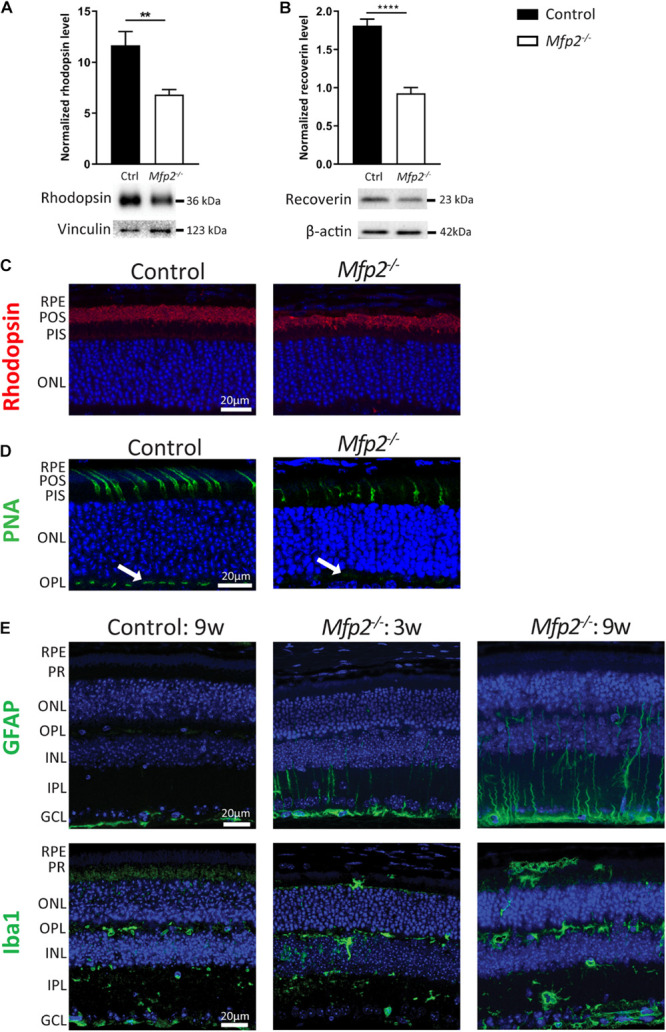
MFP2 ablation affects both rods and cones and causes secondary glial activation. Western blot analysis of (A) rhodopsin and (B) recoverin reveal decreased protein levels in 3 weeks-old Mfp2–/– retinas. Vinculin and β-actin are used as loading control in (A,B), respectively. Mean ± SEM are shown (n = 5-9 per genotype). Statistical significance was determined by unpaired t-test: ** p < 0.01, **** p < 0.0001. (C) IHC for rhodopsin reveals shorter POS length and no mislocalization of the protein. (D) PNA-labeled cones exhibit a reduction in length in Mfp2–/– retinas. Cone pedicles in the OPL (white arrows) show a decrease in signal intensity. (E) IHC for GFAP and Iba1 shows the activation of Müller cells and microglia, respectively, in the MFP2 deficient retinas of 3 and 9 weeks-old mice. In addition to their activation, microglia also migrate toward the subretinal space. Hoechst (blue) was used as nuclear counterstain (n = 3 per genotype). RPE, retinal pigment epithelium; POS, photoreceptor outer segments; PIS, photoreceptor inner segments; ONL, outer nuclear layer; OPL, outer plexiform layer; INL, inner nuclear layer; IPL, inner plexiform layer; GCL, ganglion cell layer.